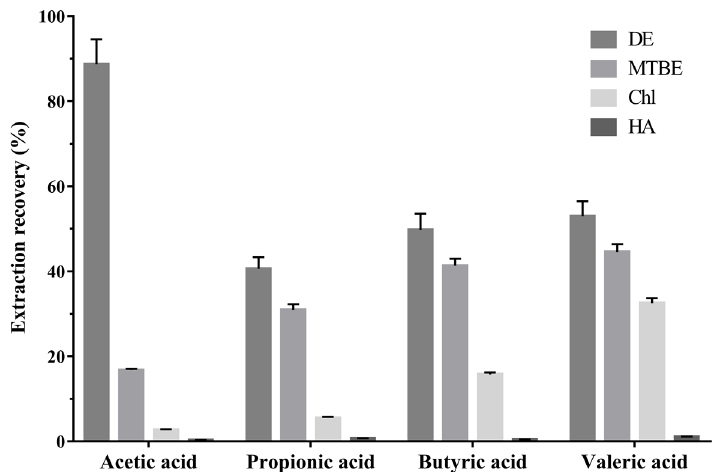
Figure 1. Extraction recovery of SCFAs with organic solvents. DE, diethyl ether; MTBE, methyl tert-butyl ether; Chl, chloroform; HA, n-hexane (mean ± standard deviation, n = 3).